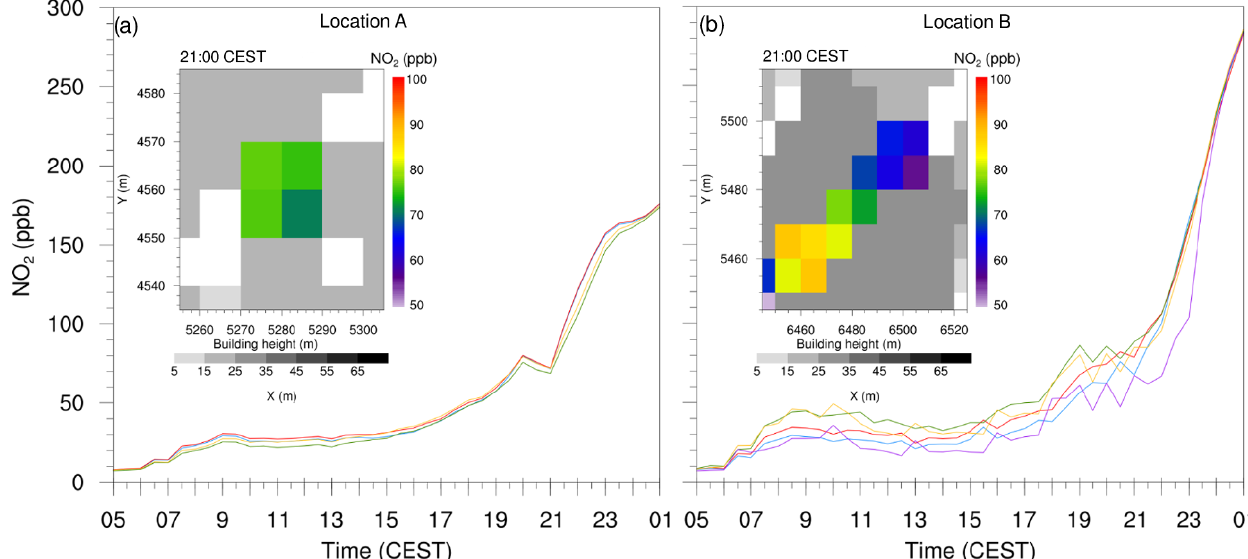
Figure 8. Time series plots from (a) four individual grid points with high concentrations at location A, and (b) five randomly selected grid points from the isolated street canyon at location B as indicated in Fig. 6c. The inset shows the close-up view of these isolated cavities at location A and B at 21:00CEST on 17 July 2017. Colours of the curves in the time series plots are randomly selected and has no relevance to the shading of the inset